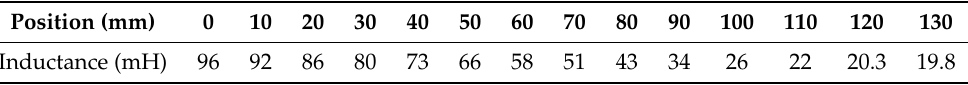
Figure 7. Variation of the inductance value depending on the plunger position and the coil current. Table 1. Inductance of the coil depending on the plunger position with a coil current equal to 10 A .